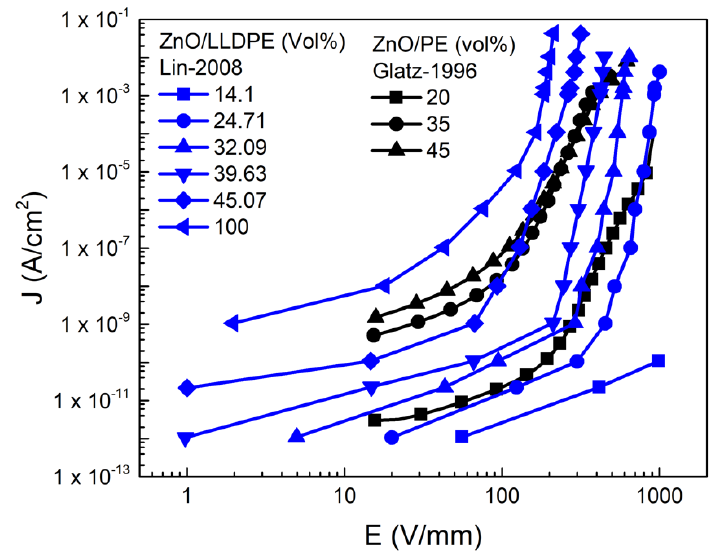
Figure 7. J–E characterization of LLDPE and PE composites with varying ZnO filler concentrations. Data extracted from Refs. [50,51]. Table 4. Nonlinear conduction properties of composites involving ZnO as a filler. Matrix Filler